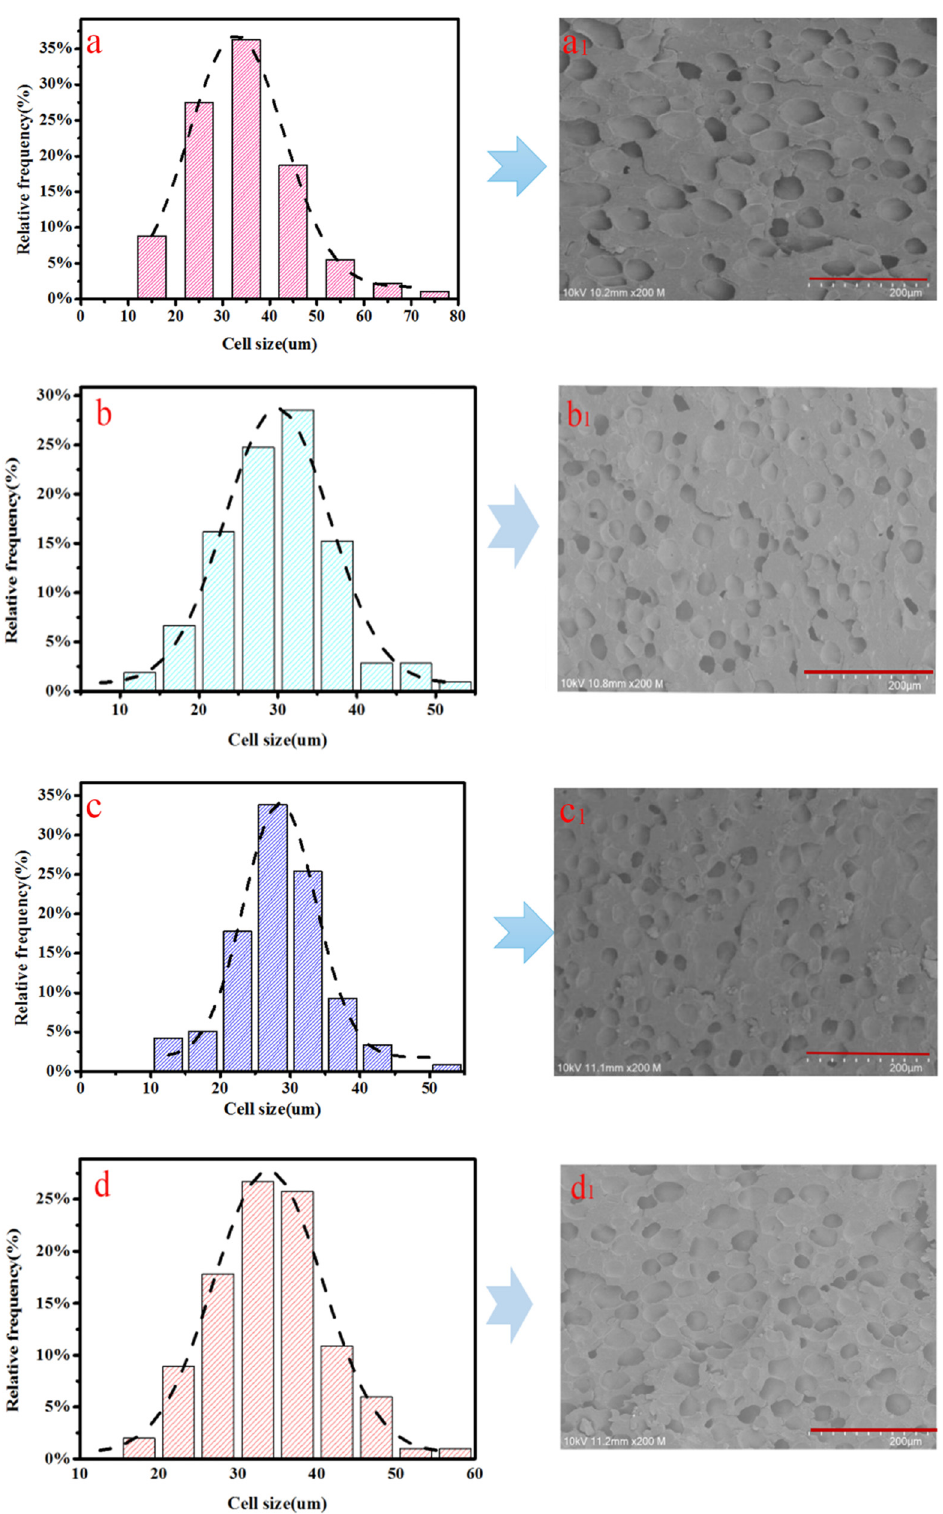
Figure 13: Quality of cells in di ff erent regions of the same isothermal plane for foamed PP composites: ( a – d ) distribution of cells at various regions and ( a 1 – d 1 ) electron micrographs of cells in di ff erent